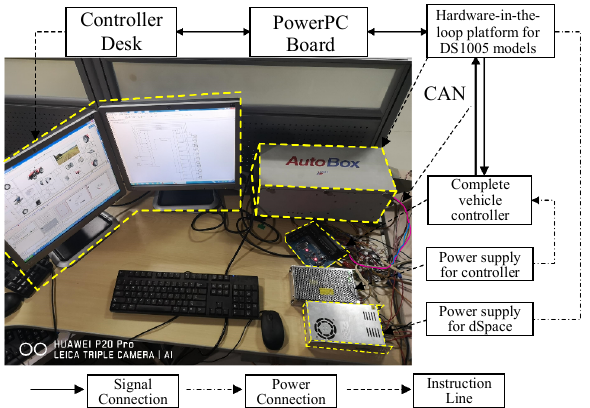
Figure 9. The HIL platform of the Hybrid tractor.